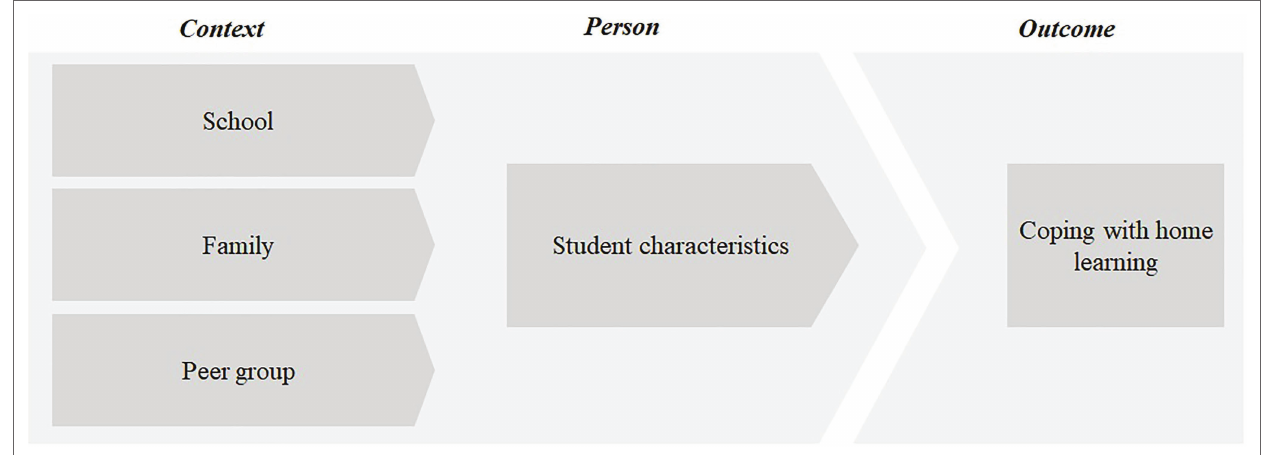
FIGURE 1 | Theoretical